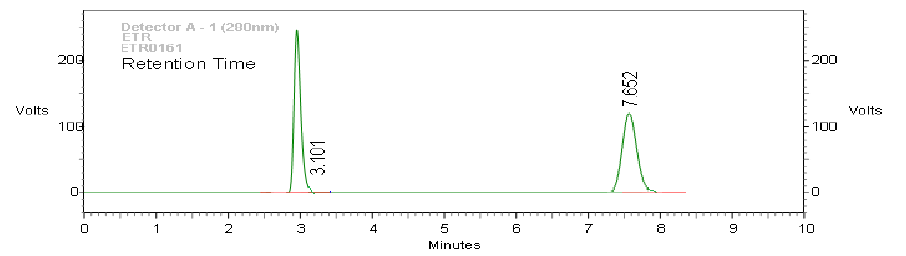
Figure 4. Representative Chromatogram of Etoricoxib Fomulation (ETOZOX - 60 mg) (20 µg ml -1 ) (Rt = 3.101 mins) with Bromohexine (IS) (10 µg ml -1 ) Rt = 7.652 mins).